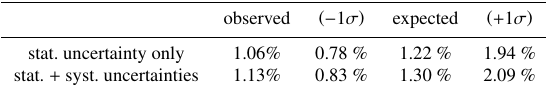
Table 2. The observed 95% CL upper limits on the FCNC top quark decay t → qZ BR are shown. The expected values with the ± 1 σ limit, which include both the statistical and the systematic uncertainty contributions, are also presented.